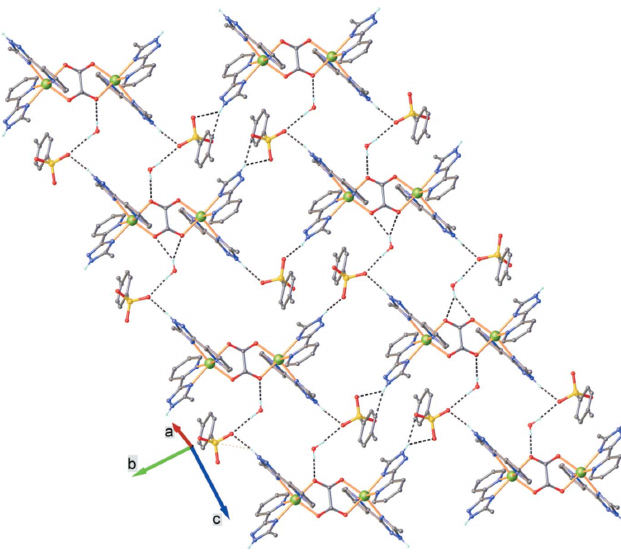
Figure 2 Two-dimensional supramolecular network viewed along the a axis.